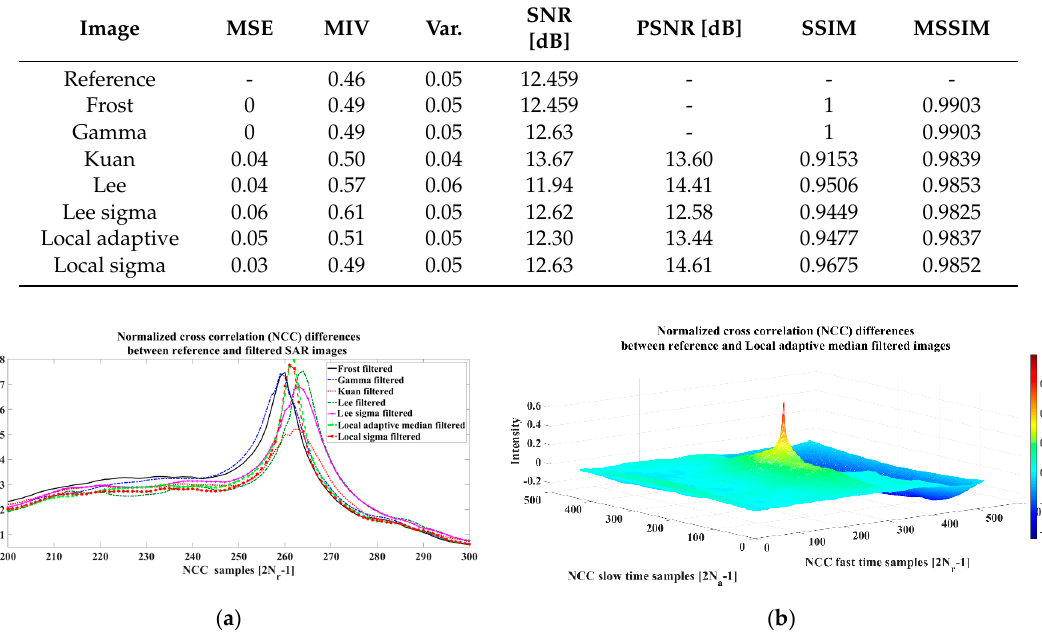
Table 4. SAR images’ pixel-based objective quality metric results.